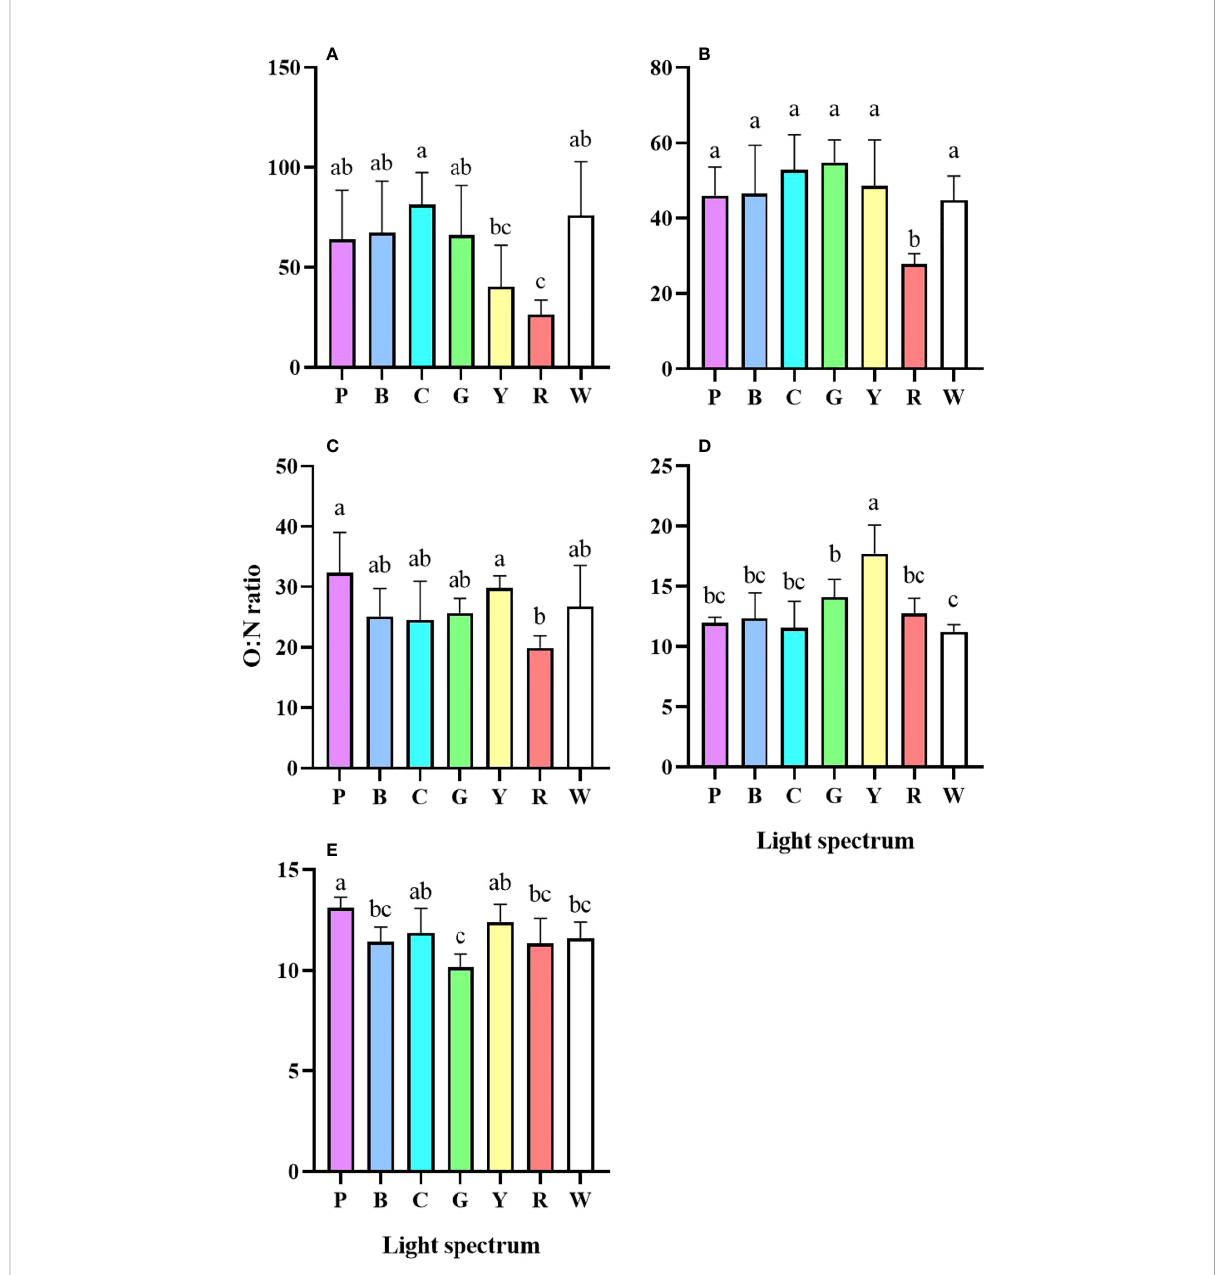
FIGURE 3 Oxygen-nitrogen ratio (O:N ratio) of P. trituberculatus larvae under different light spectrum (mean ± SD) (n=4). (A) Zoea I, (B) Zoea II, (C) Zoea III, (D) Zoea IV, (E) Megalopa. P, Purple; B, Blue; C, Cyan; G, Green; Y, Yellow; R, Red; W, White. Different letters indicate signi fi cant differences between treatment groups ( P